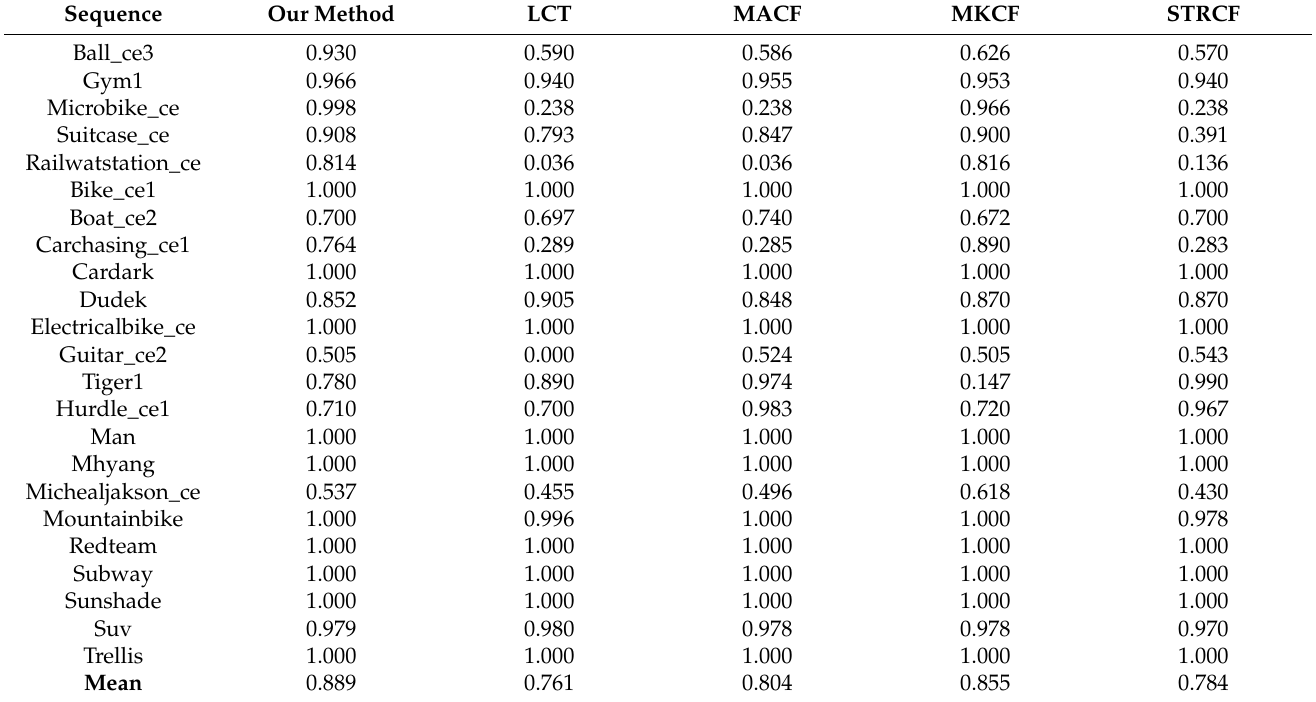
Table 3. Distance precision of five trackers for twenty-three video sequences at threshold of 20 pixels.